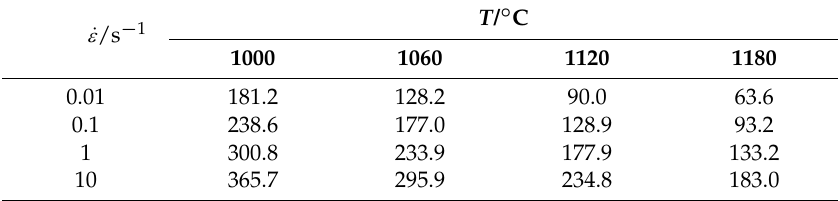
Table 3. The calculated rheological stress ( σ ) of 21-4N steel under different hot deformation conditions (MPa). Table 4. The relative error ( ARRE ) between theoretical and corrected experimental.